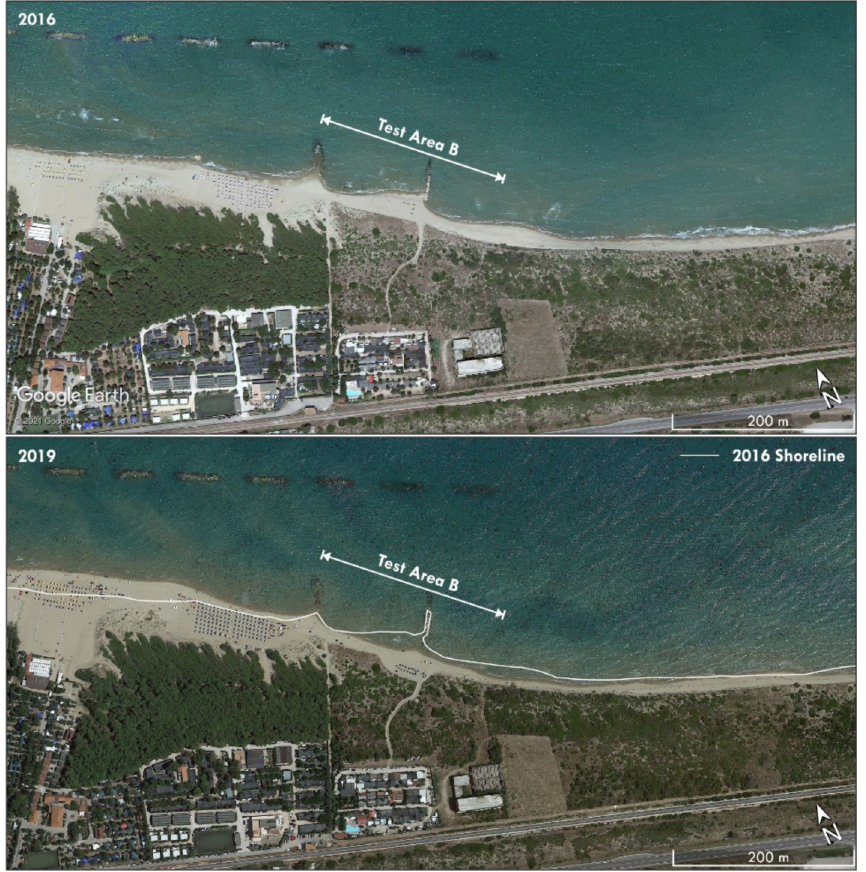
Figure 8. Evidence of shoreline and beach changes from 2016 to 2019 (Google Earth images dating back to 20 June 2016 and 20 July 2019) along the coastal stretch that includes test area B. On the Google Earth image from 2019, the white line indicates the shoreline of